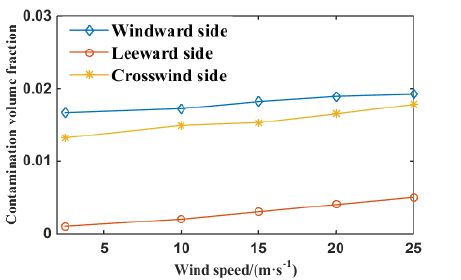
Figure 23. Contamination volume fraction of 2# insulator under different wind